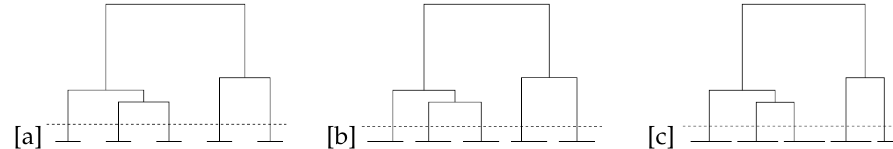
Figure 5. Hierarchical clustering of prototypes. Coordinates of each cluster prototype are represented with respect to the x-axis.